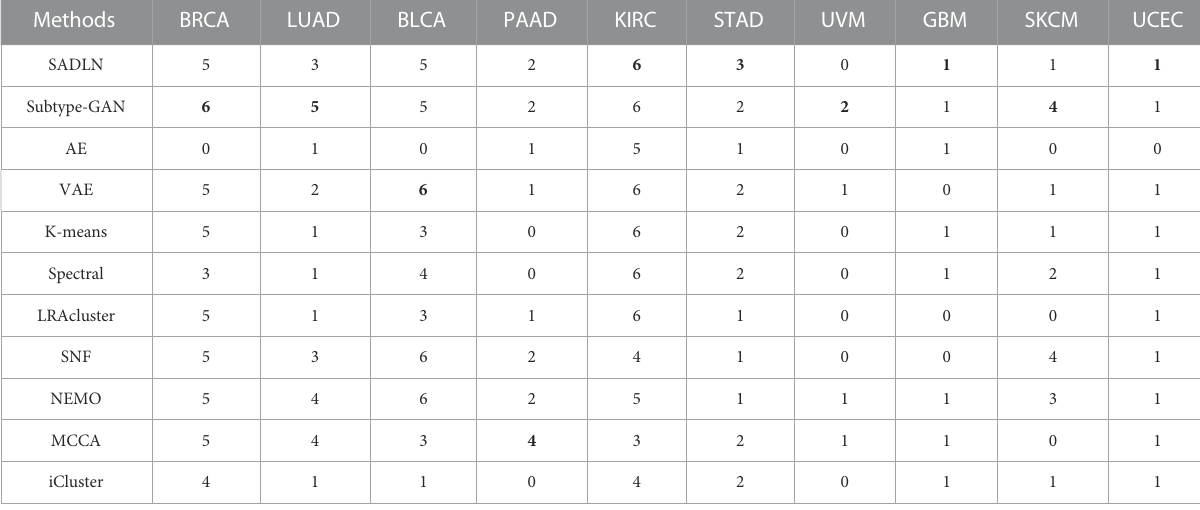
TABLE 6 The clinical parameters enrichment analysis of SADLN and other methods of ten cancer datasets on TCGA (bold indicates that this method performs best on the corresponding cancer dataset).